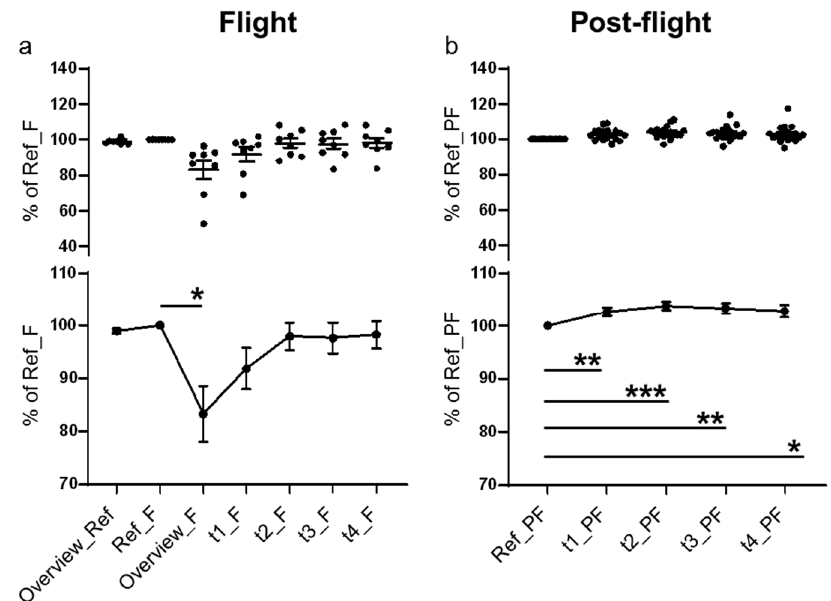
Figure 4. Maximum intensity projection for F-actin. In total seven measurement points were recorded for the actin cytoskeleton labelled with SiR-actin in microgravity and five measurements were performed post-flight. All measurements were “bleaching corrected” before the data analysis. The area covered by the cellular F-actin was determined by comparison of the z-projections of the recorded image stacks for each time point. Upper parts of the graphs show single values and lower parts show averaged values and statistical evaluation of ( a ) the in-flight data and ( b ) the post-flight data. Error bars represent SEM. p -values ≤ 0.05 were considered as significant ( p ≤ 0.05 = *, ≤ 0.01 = **, ≤ 0.001 = ***)